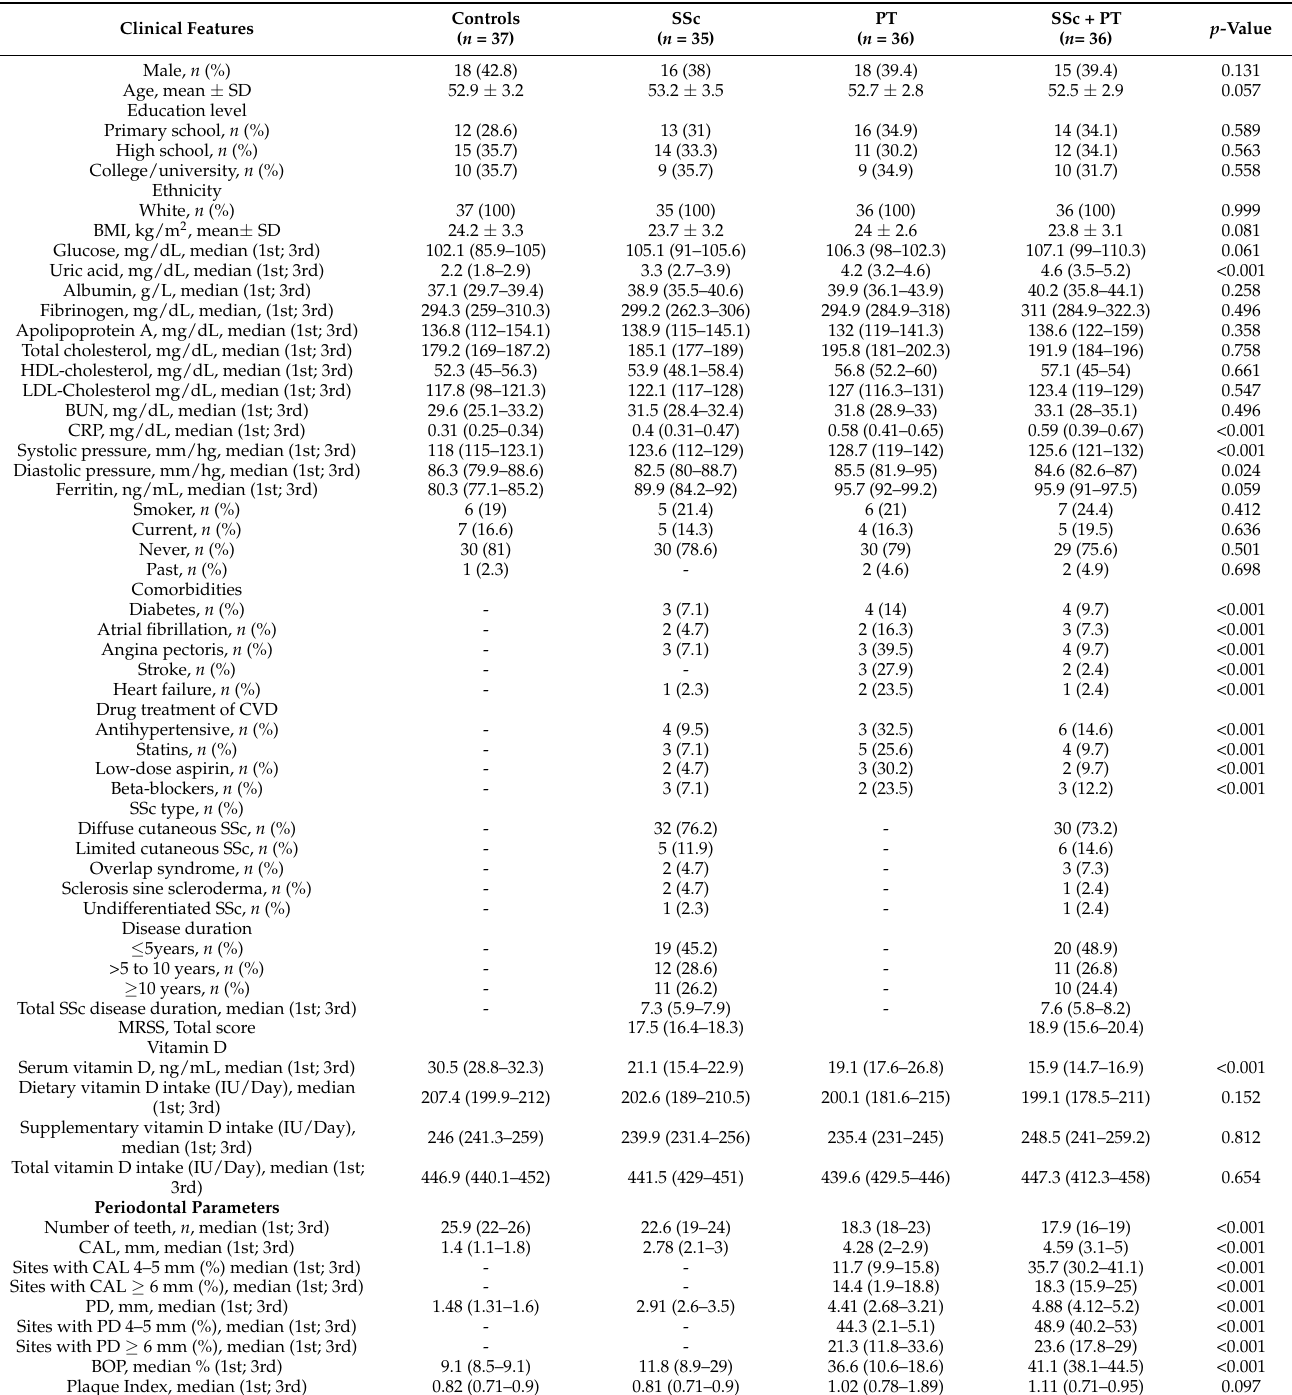
Table 1. Clinical features of all enrolled patients and a comparison among them. p -value < 0.05, statistically significant. Blood values are represented, such as median and interquartile range (IQR) (1st;